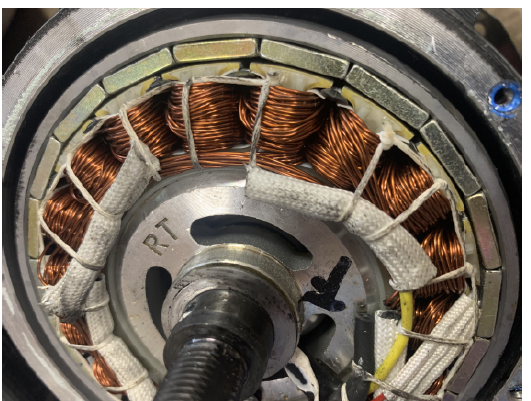
Figure 16. SPM motor in a wheel hub (18 − slots/20 − poles